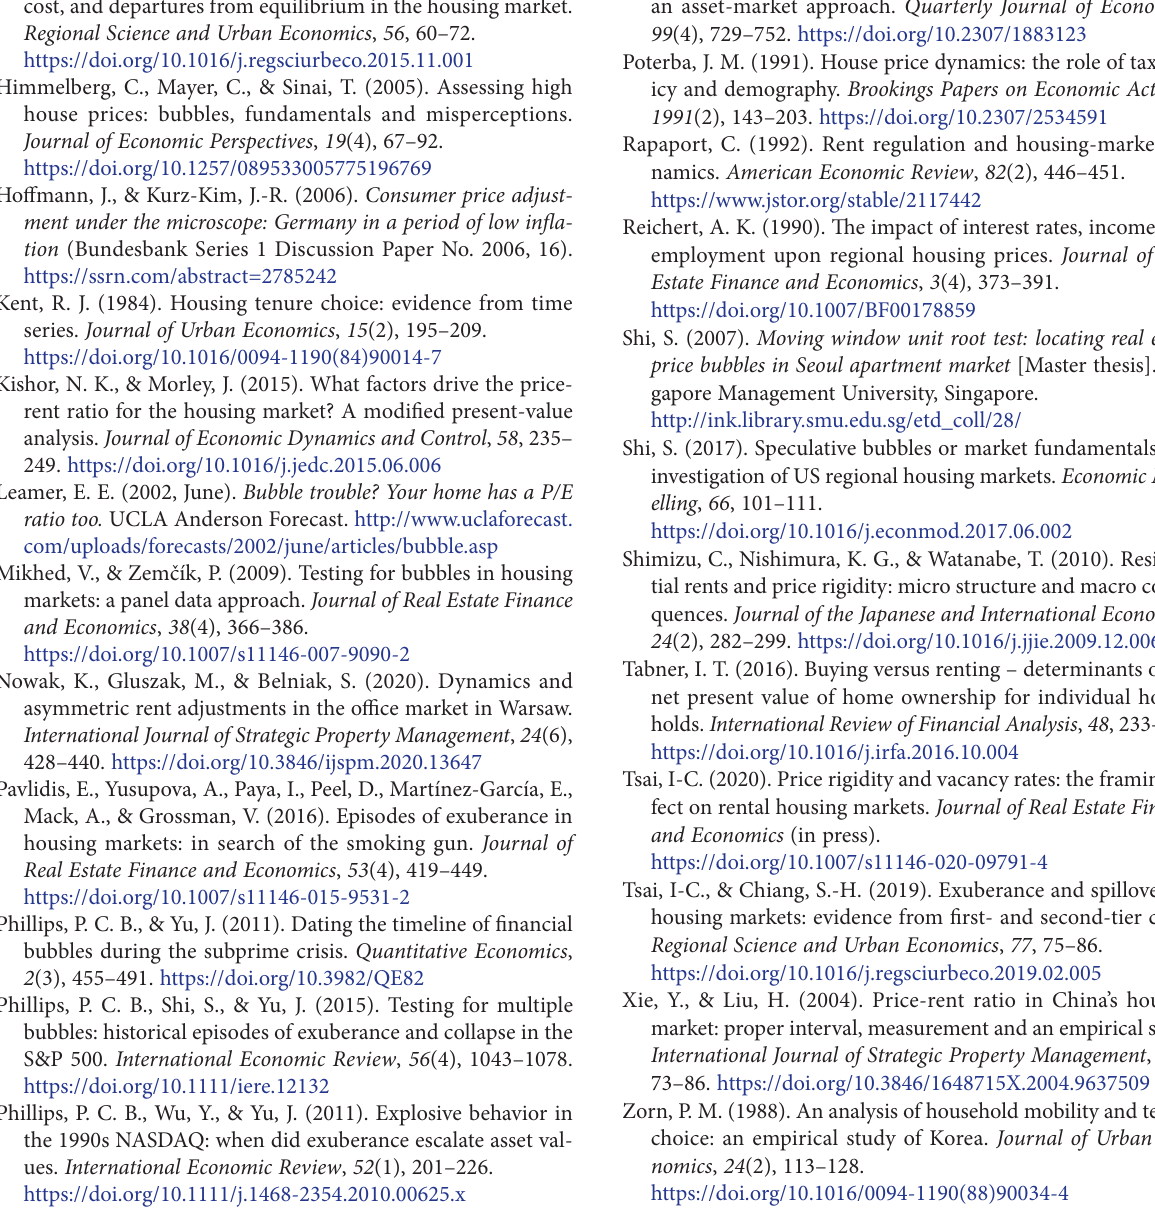
Tabner, I. T. (2016). Buying versus renting – determinants of the net present value of home ownership for individual house- holds. International Review of Financial Analysis , 48 ,